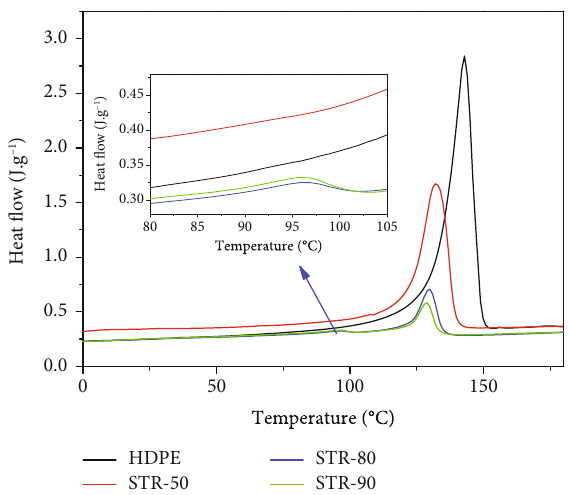
Figure 3: DSC analysis curves of starch-based composite fi bers.